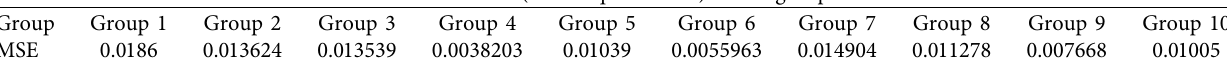
Figure 3: Ten-fold cross-validation results. Table 7: MSE (mean square error) of ten groups.